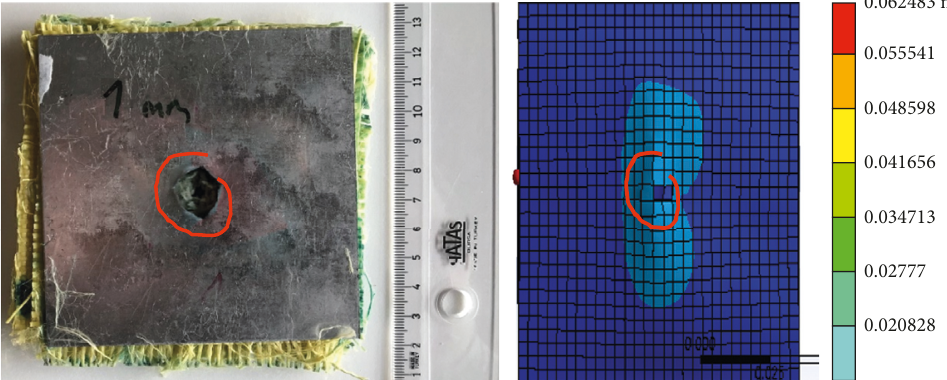
Figure 11: Total deformation of sample 3 as shown in experimental and simulation